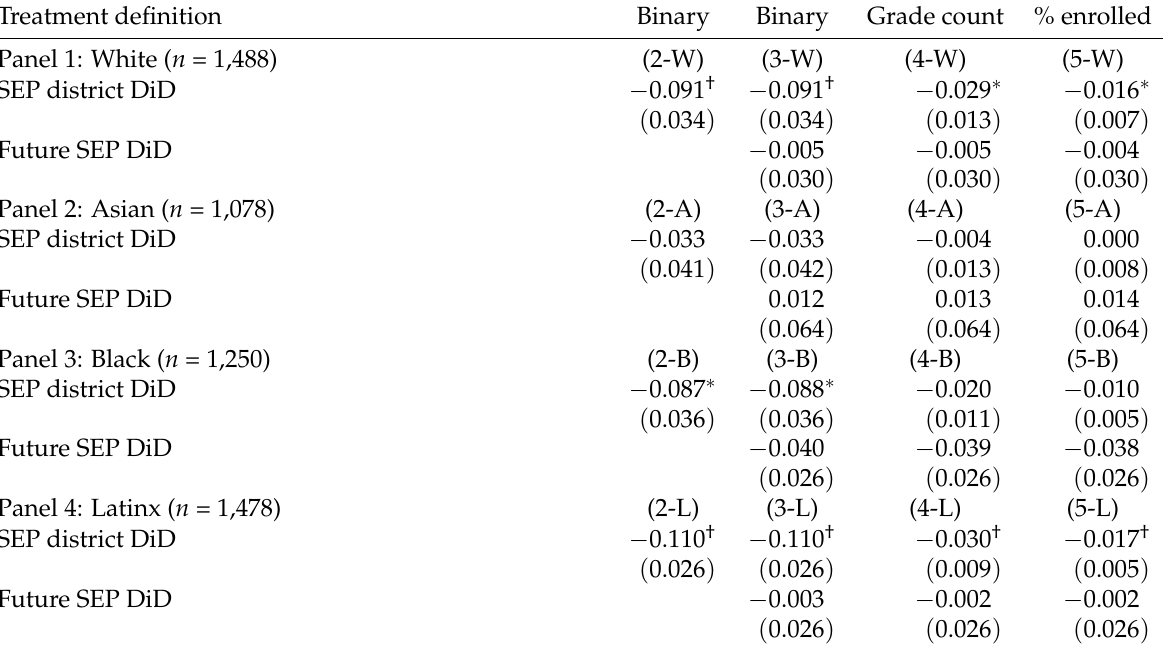
Table 4: DiD of mean math achievement on SEP status by